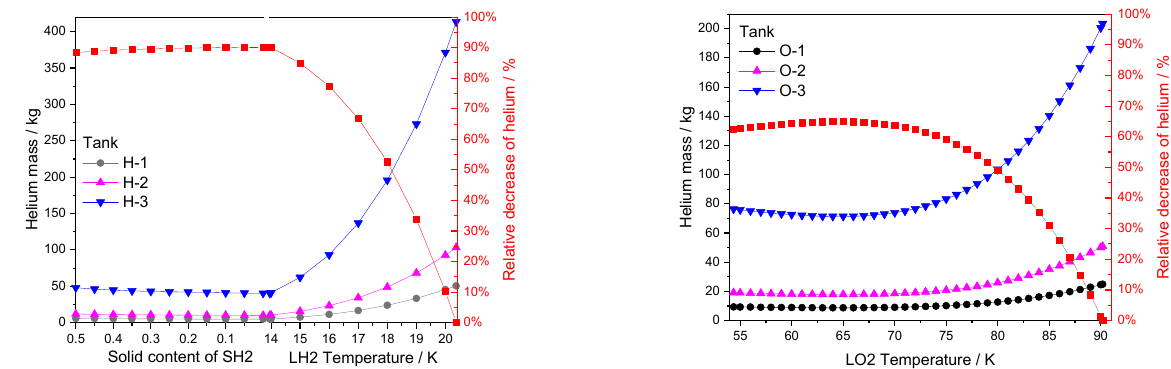
Figure 8. Relationship between LH2/LO2 densification degree and mass consumption of pressur- ized helium.